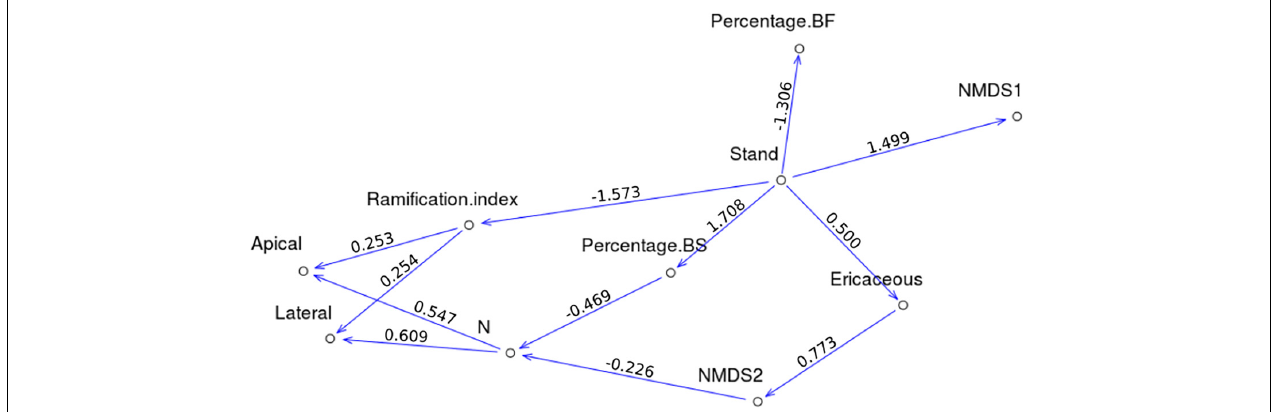
FIGURE 6 | Direct acyclic graphs corresponding to Mod1, only significant links between variables are shown, path coefficients are indicated above each